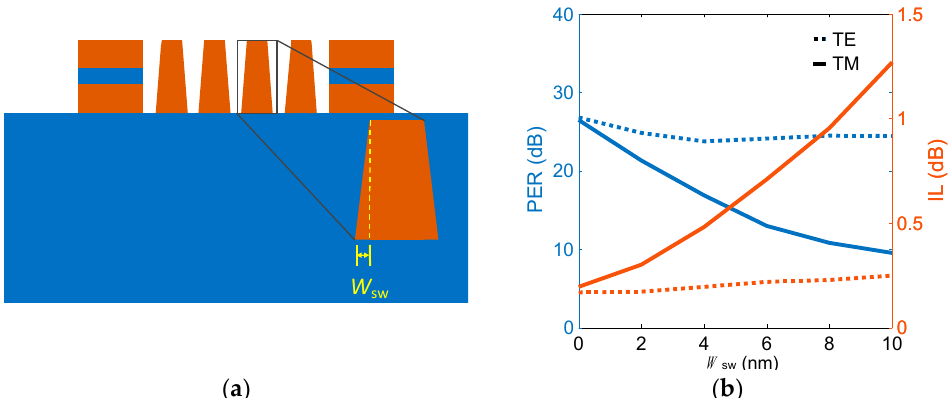
Figure 10. ( a ) Cross-sectional diagram in xy plane and zooned-in view of a SWGM, where W sw denotes the difference between the bottom and top of the SWGMs. ( b ) PER and IL versus W sw .